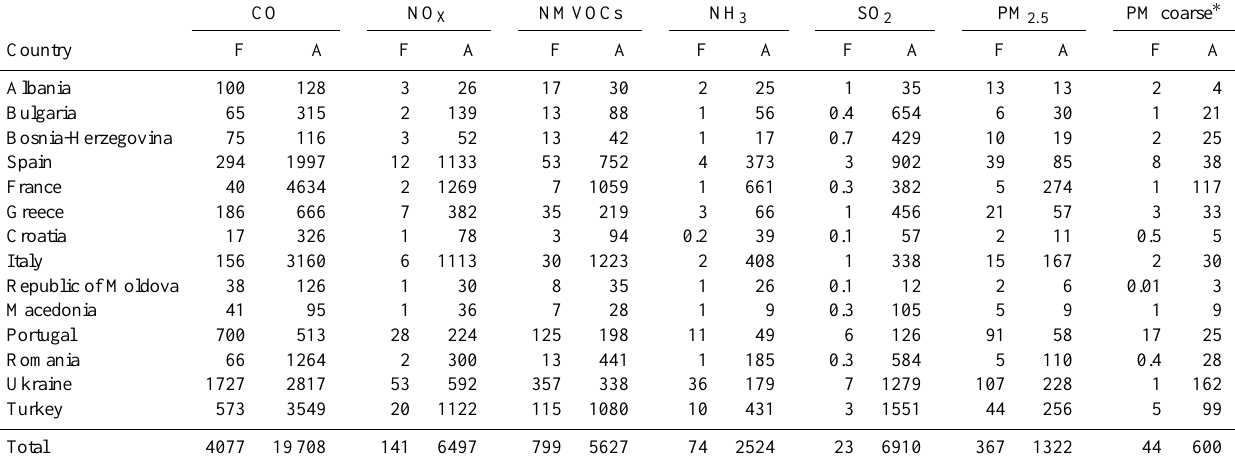
Table 9. Average (2003–2011) total annual emissions in Gg by country for the main pollutants, for the fire emissions (F) and the EMEP anthropogenic emissions (A). Only countries for which fire CO emissions are larger than 30Ggyr − 1 on average, and for which anthropogenic emissions are available in the EMEP inventory, are